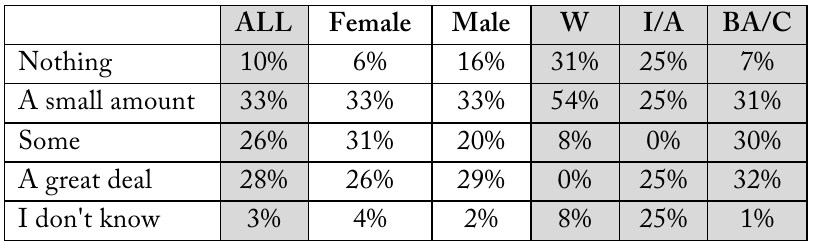
Table 8: Perceived amount of agency to effect